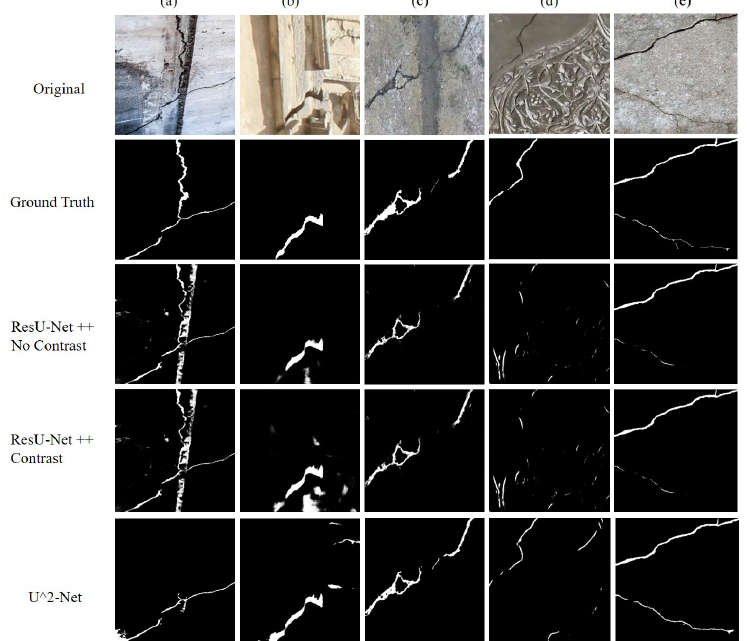
Figure 15. Results on several samples of the used crack detection dataset, with different patterns— group-4. In each column, we present the results based on: ( a ) Image with a branched crack (a multi-depth view), ( b ) Image with a crack inside carvings, ( c ) Image with a crack and marker, ( d ) Image with a crack inside ornaments, ( e ) Image with a branched